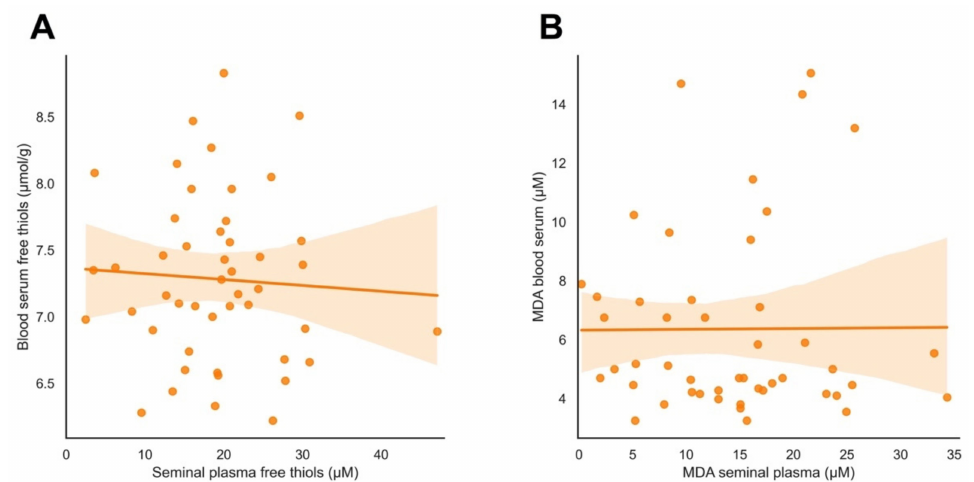
Figure 2. Association between systemic and local-free thiol and MDA levels. ( A ) No signifi- cant correlation between serum-free thiols and seminal plasma-free thiols (r = − 0.060, p = 0.690); ( B ) No significant correlation between MDA levels in serum and seminal plasma (r = 0.007, p = 0.962). Lines represent best-fitting lines from linear regression. Color-shaded areas indicate 95% confidence